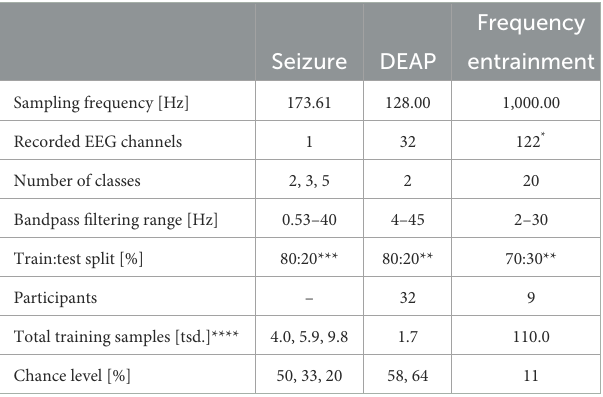
TABLE 1 Overview of the utilized